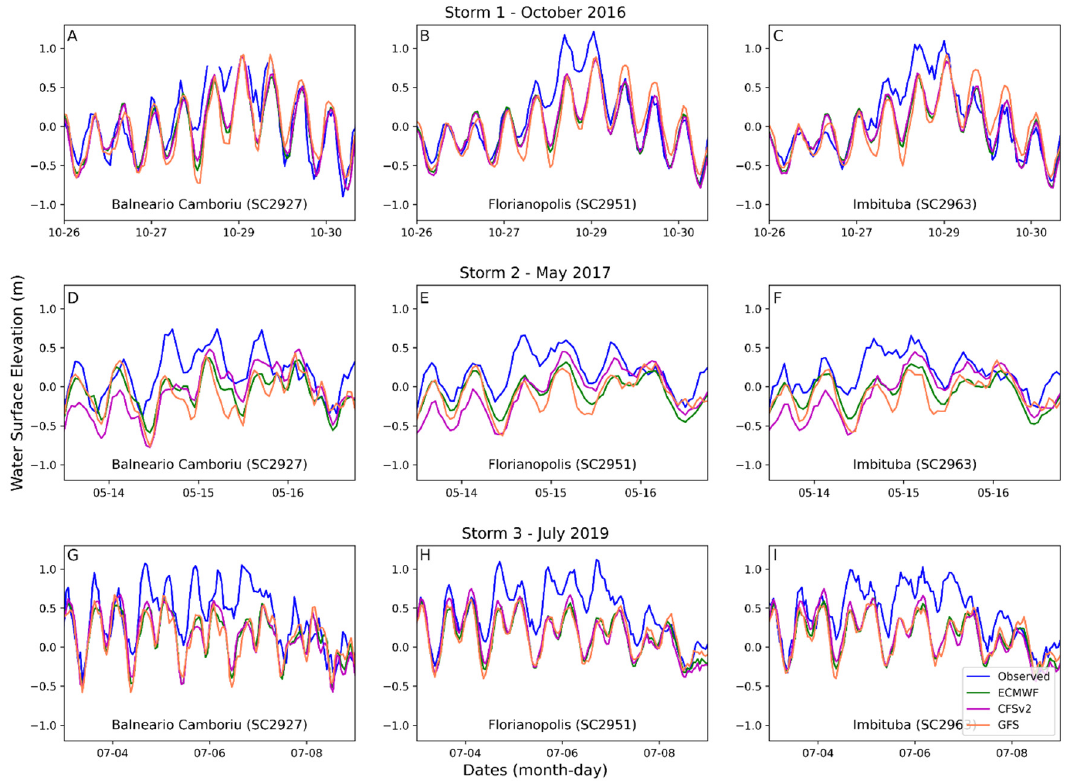
Figure 10. Total water level time series at three different recording stations ( A – I ).